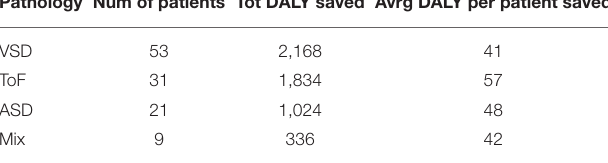
TABLE 2 | Average DALY’s saved per